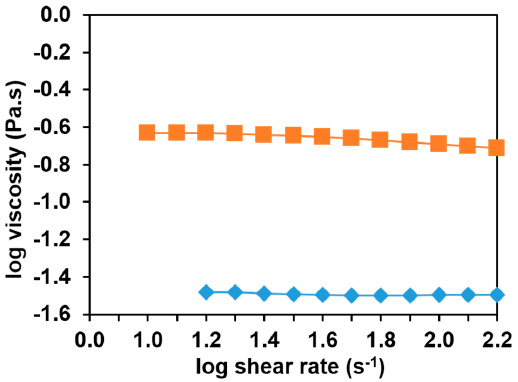
Figure 3. Logarithm of apparent viscosity of 15% ( ■ ) and 8% ( ♦ ) pullulan solutions as function of the logarithm of shear rate.